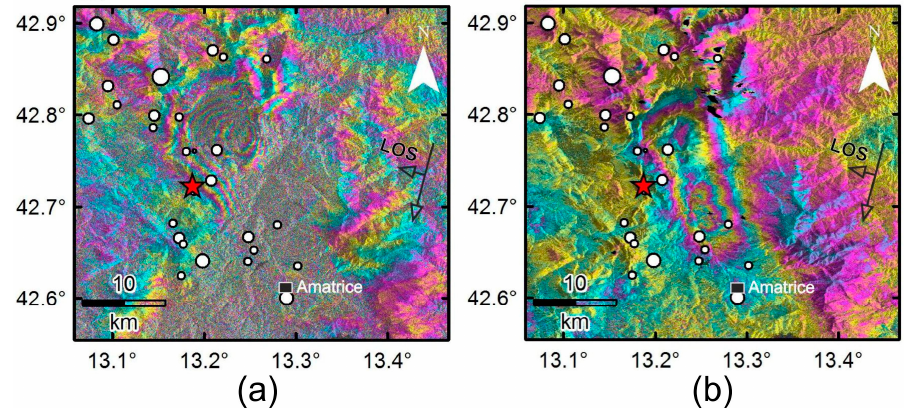
Figure 3. Interferograms generated from descending orbits: ( a ) the co-seismic pair of Sentinel-1 (2016/08/09 VV and 2016/09/02 VV); ( b ) the co-seismic pair of ALOS-2 (2016/05/25 HH and 2016/08/31 HH). Table 1. Detailed SAR information used for this study. θ , B , and T are the incidence angle, normal baseline, and temporal baseline, respectively.